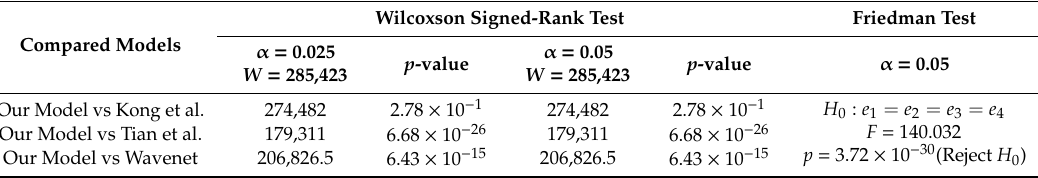
Table 9. Result of the Wilcoxon signed-rank test and Friedman test using ISO-NE testing dataset 2. Compared